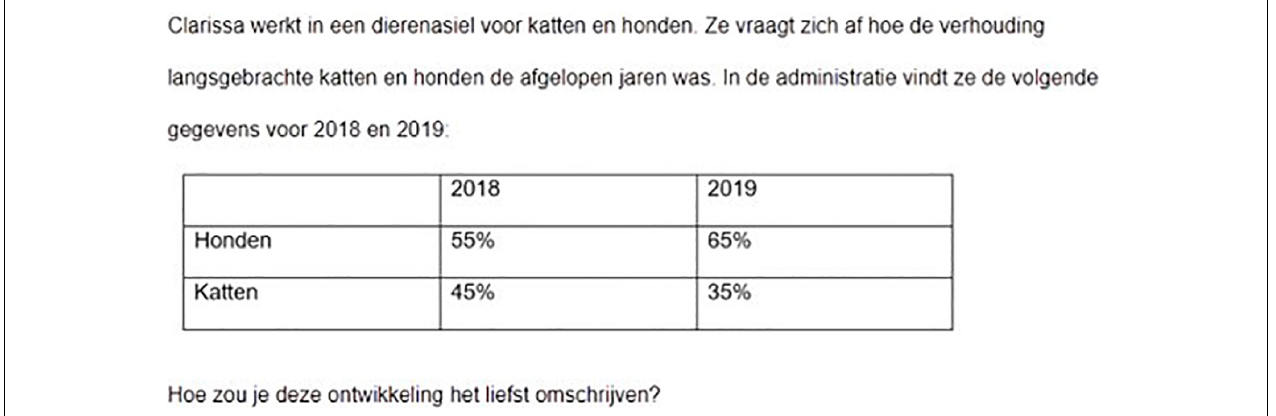
FIGURE 1 | Screenshot of a symmetrical scenario used in our study (taken from experiment 2). Translation: Clarissa works in an animal shelter for cats and dogs. She wonders how many cats and how many dogs were brought into the shelter in the past years. In the computer, she finds the following data for 2018 and